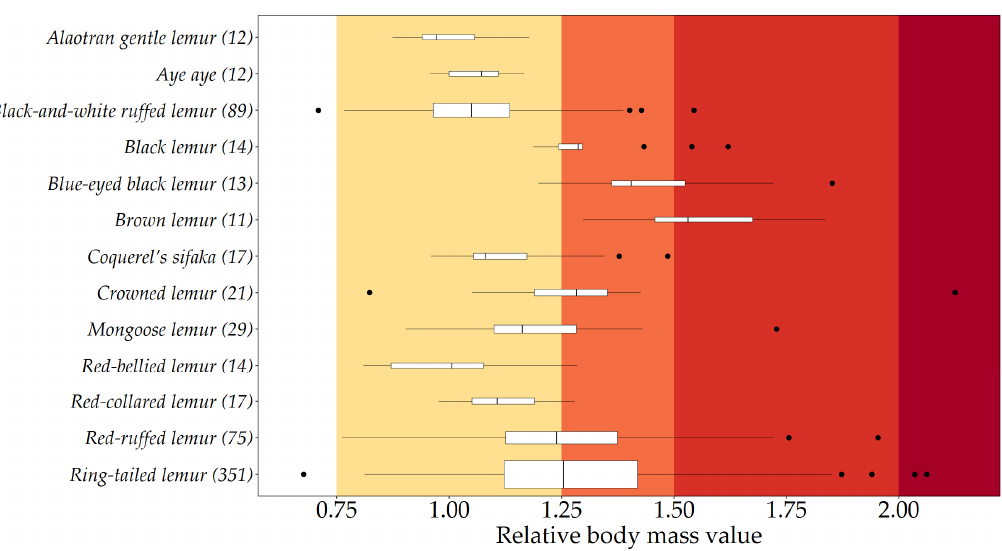
Figure 3. Phylogenetic tree of 13 lemur species in our comparative analyses, with their species-typical median relative body mass values shown as tip-points. The colour of a species’ tip-point represents its species-typical body condition: the healthy range (species-typical relative body mass 0.75–1.25) is shown by yellow shading; overweight by orange (1.25–1.5); obese by red (1.5–2); and morbidly obese (>2) by the darker red. 3.2.2. Comparative Analyses: Results of Hypothesis-Testing No aspect of wild ecology significantly predicted species-typical median relative body mass (Table 4); however, we did uncover one trend. Species that experience large between-year variation